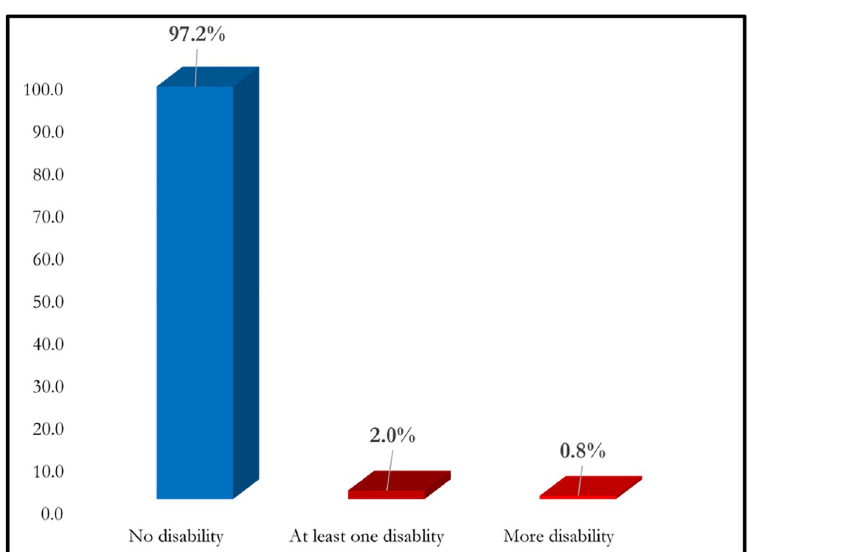
Fig 5. Distribution of early childhood disability in Bangladesh.